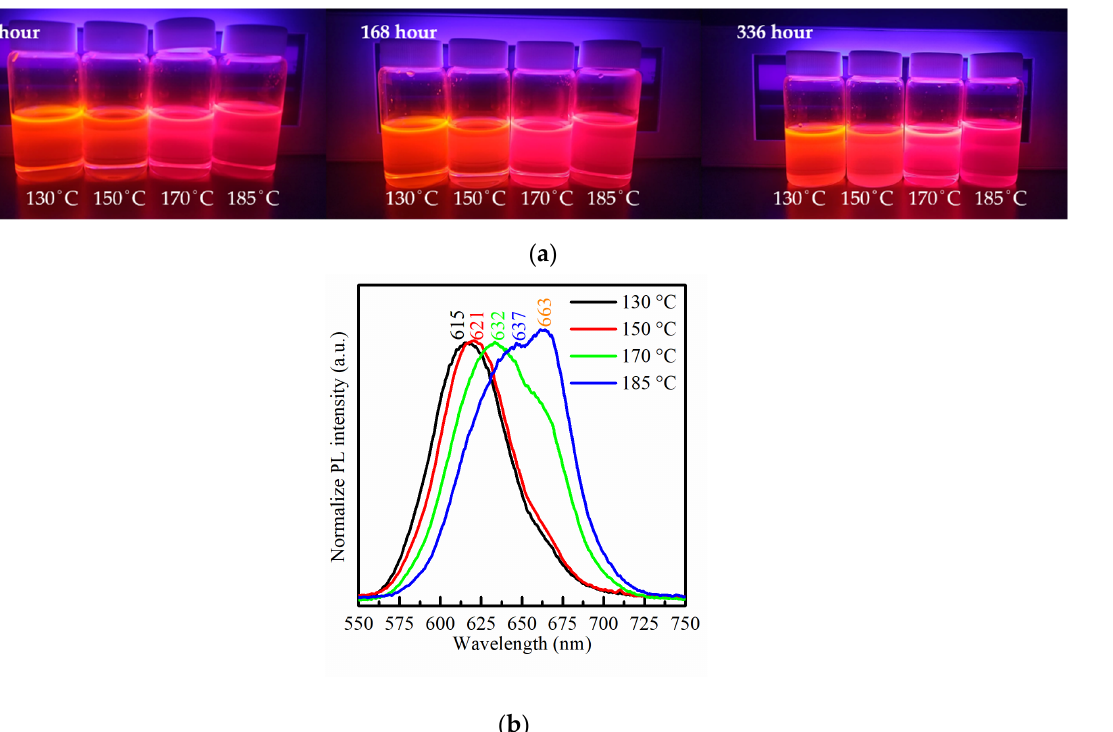
Figure 2. ( a ) Colloidal solutions at different synthesis temperatures in toluene under UV lamp ( λ = 365 nm). ( b ) CsPbI 3 - QD (0 hour) at different synthesis temperatures.